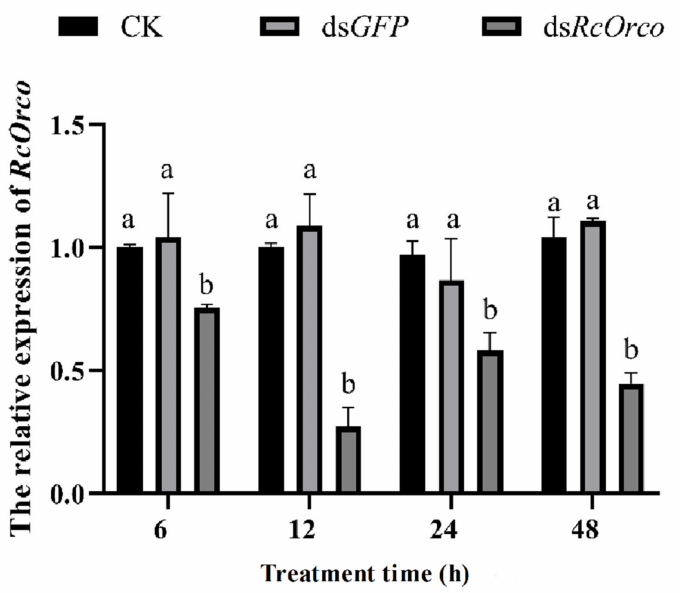
Figure 3. The effect of dsRcOrco on the relative expression of RcOrco in R. chinensis. The letters above the columns indicate different expressive differences.